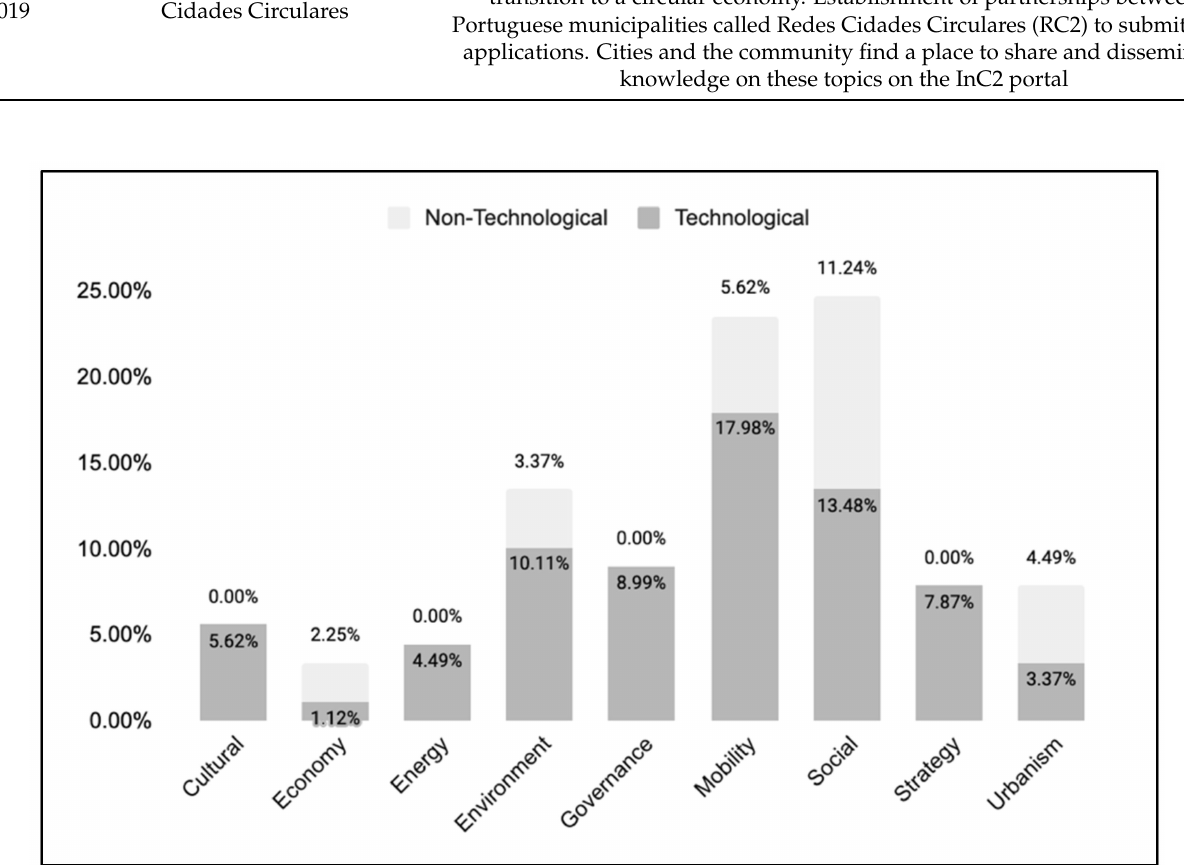
Figure 2. Area and type of the smart-city